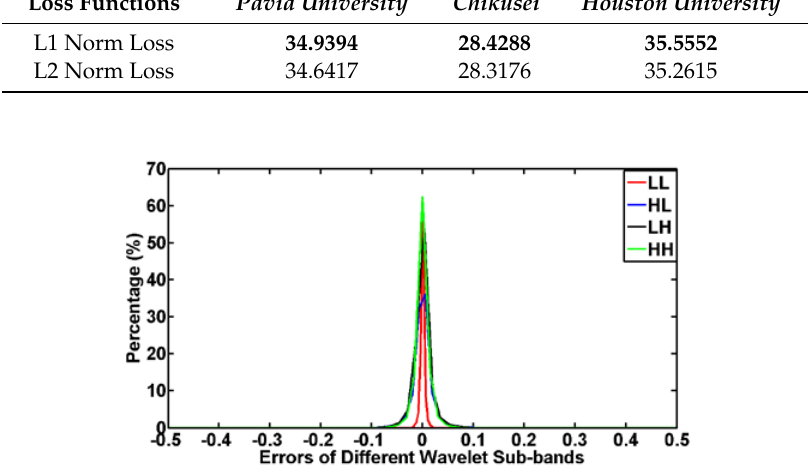
Table 9. PSNR (dB) of MW-3D-CNN trained with different losses. The upscaling factor is two. Loss Functions